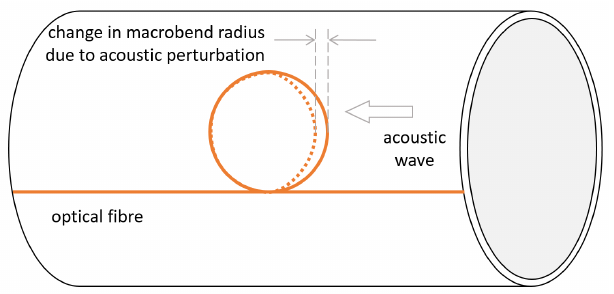
Figure 10. Diagram demonstrating the geometry of an FOS described in